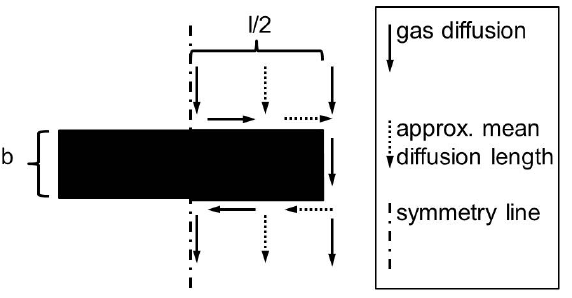
Figure 9. Schematic of the approximation oft the mean diffusion length around an object with length l and width b . For diffusion around an object, with a quadratic cross-section, one applies l =